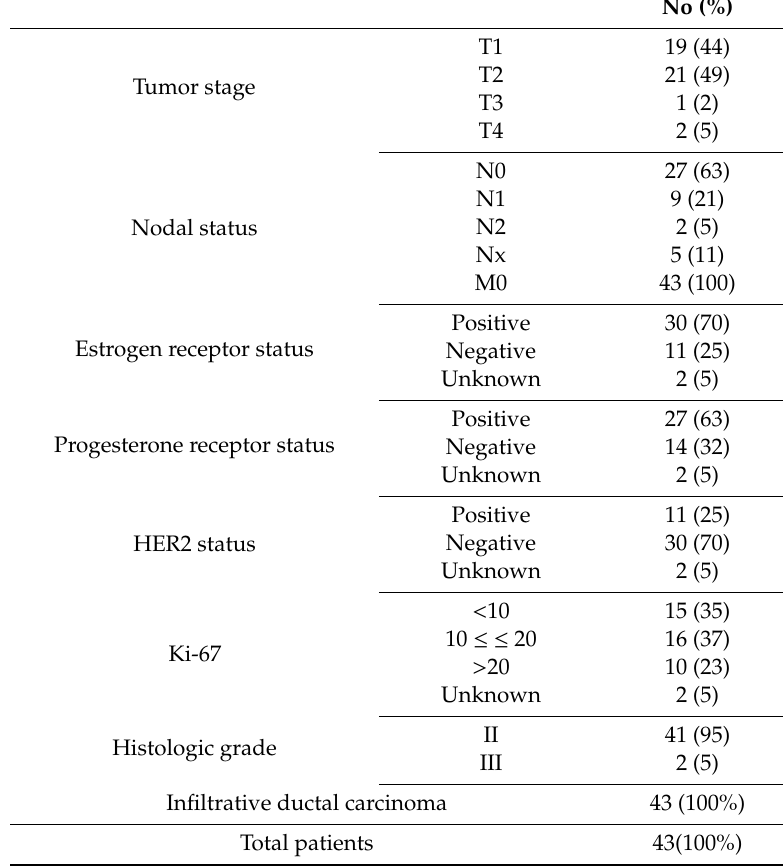
Table 1. Clinical characteristics of the